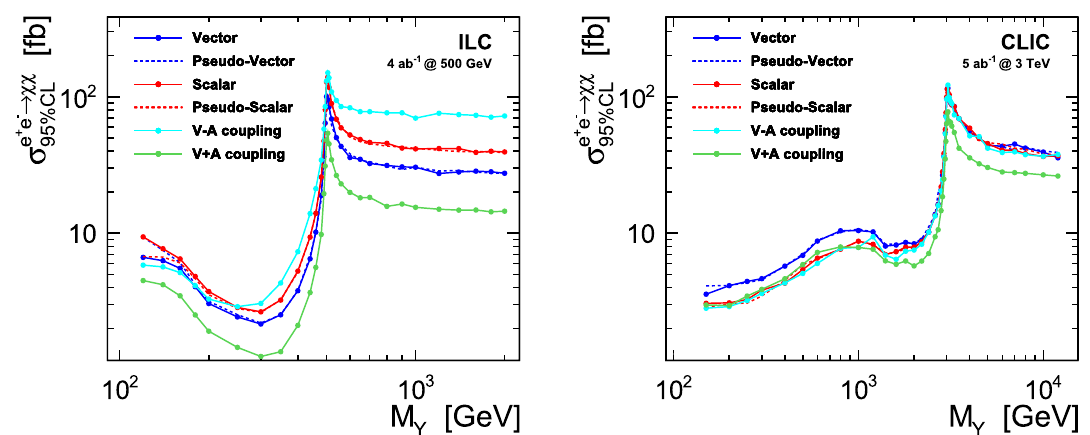
Fig. 13 Limits on the cross section for light fermionic DM pair-production processes with s -channel mediator exchange for the ILC running at 500GeV (left) and CLIC running at 3TeV (right), for relative mediator width, (cid:4)/ M = 0 . 03, and different mediator coupling scenarios, as indicated in the plot. Combined limits corresponding to the assumed running scenarios are presented with systematic uncertainties taken into account